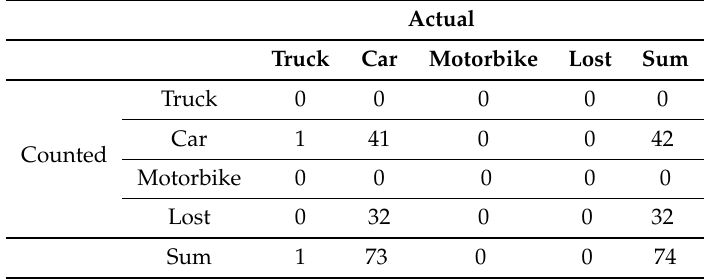
Table 5. Counting results per vehicle type from a toll station with 1500 ms request interval.